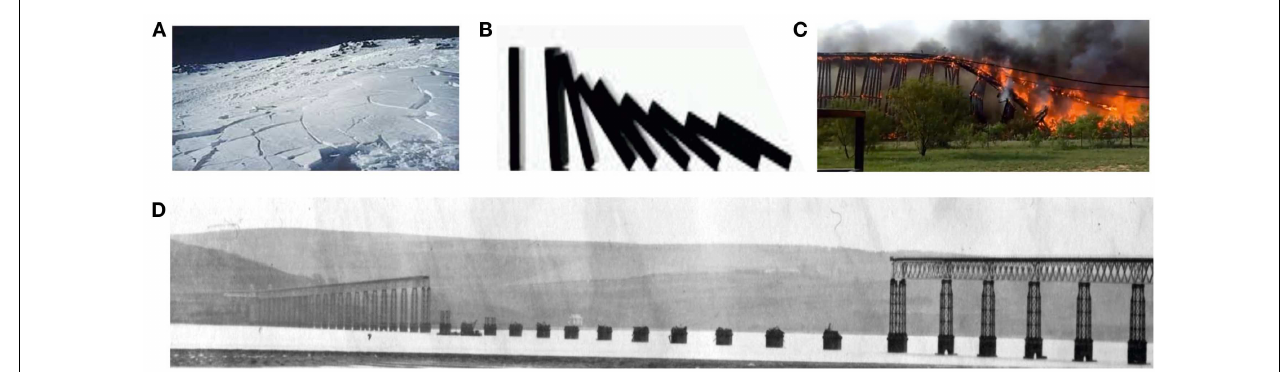
FIGURE 1 | Examples of gravitationally driven failure waves occurring in nature and in structural systems are shown . (A) A slab snow avalanche. (B) A falling domino. (C) The failure of the San Saba Bridge (Texas, May 2013). (D) TheTay Bridge disaster. Dundee, Scotland, 1879 (from